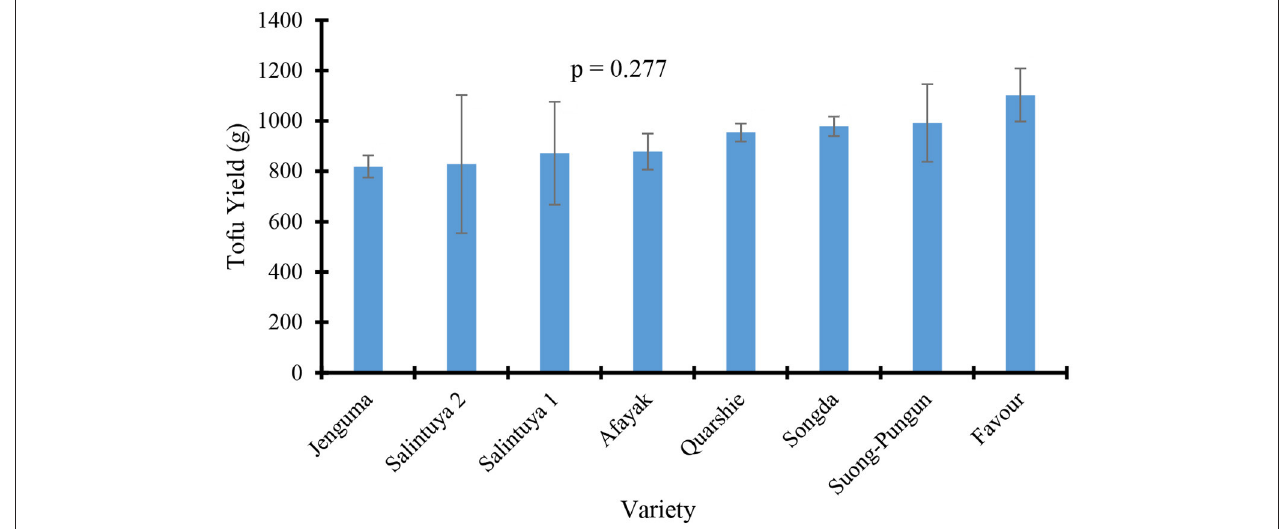
FIGURE 4 | The yield of Tofu as affected by soy variety. Bars are means ± SD; n = 3. No statistical differences after ANOVA and means compared using LSD test ( p > 0.05).